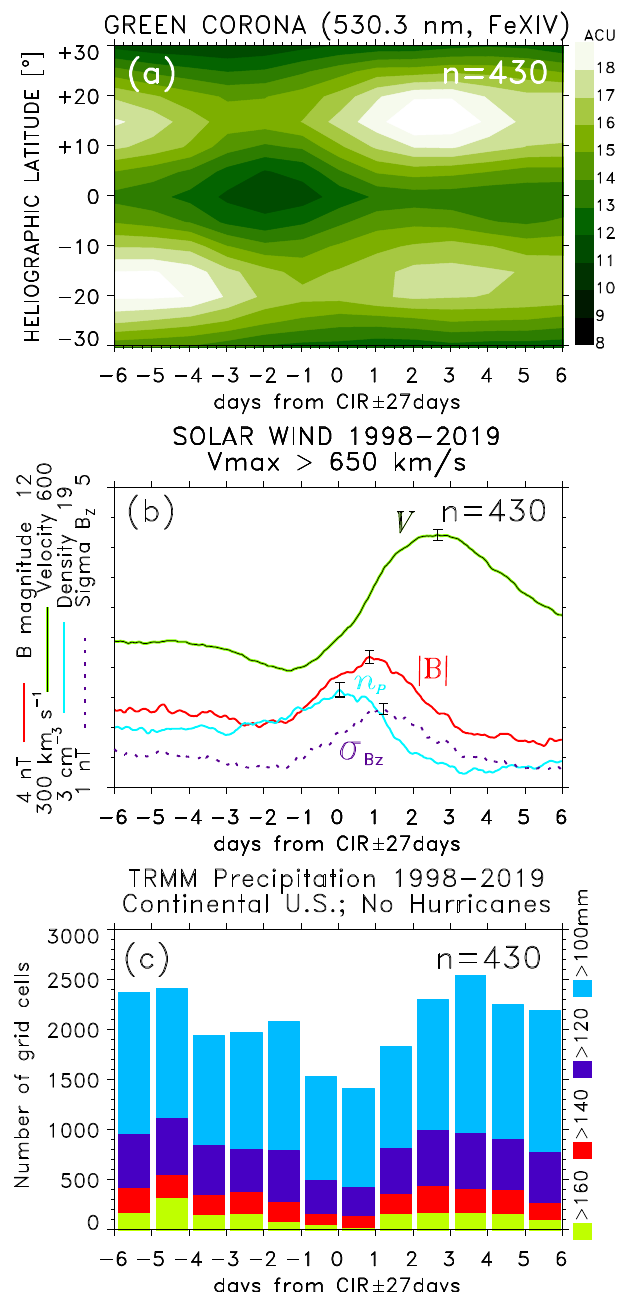
Figure 8. The same as Figure 6a–c except the SPE analysis keyed to times lagged by ±27 days relative to arrivals of HSS/CIRs of V max > 650 km/s.